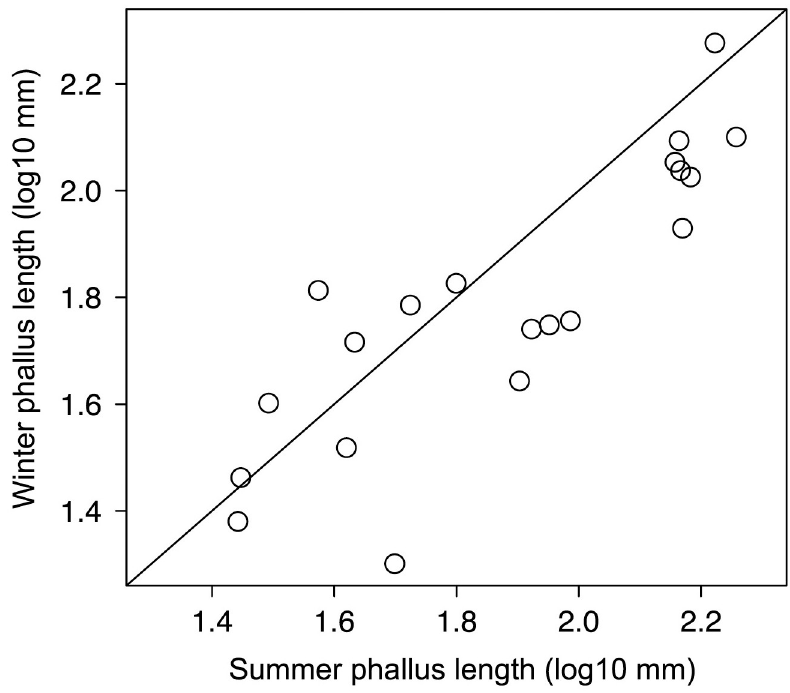
Fig 3. Log-log plot of winter versus summer phallus measurements for North American ducks relevant to this study (no Oxyura or Dendrocygna ). The line displayed is the 1:1 relationship, suggesting that seasonal size change is greater for species with larger phalluses. The regression equation for estimating winter means is y = 0.7836x + 0.3195; r 2 = 0.70.